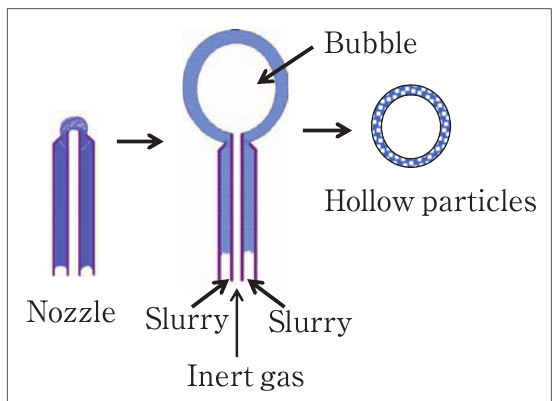
Fig. 12 Illustration of nozzle process to prepare hollow